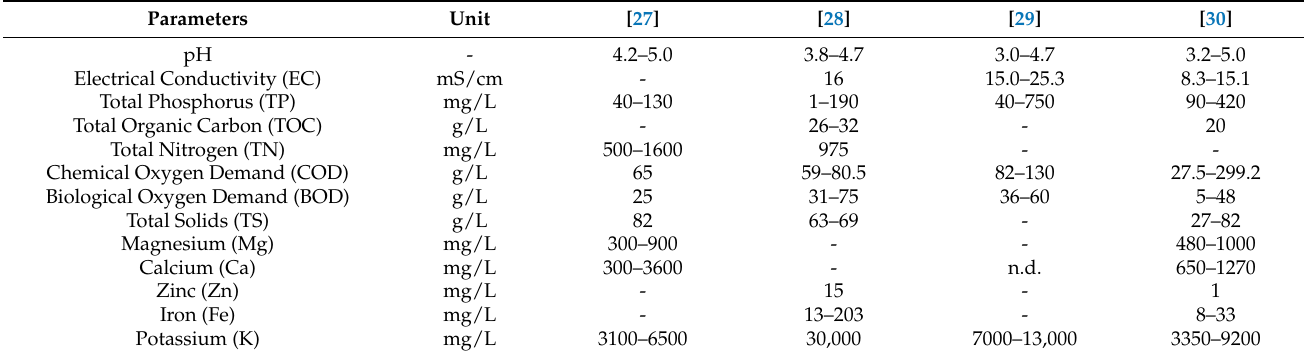
Table 2. Physicochemical characteristics of sugarcane